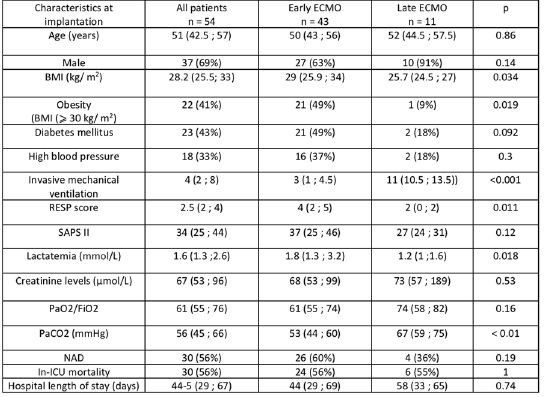
Table 1: Selected characteristics at implantation of the whole population and univariate analyses between early ( < 10 days of mechanical ven- tilation) and late (beyond 10 days) VV-ECMO. Results are expressed as median ([Q25; 75] or number (%). CO‑50 DD ECMO: Prevalence and evolution of diaphragmatic